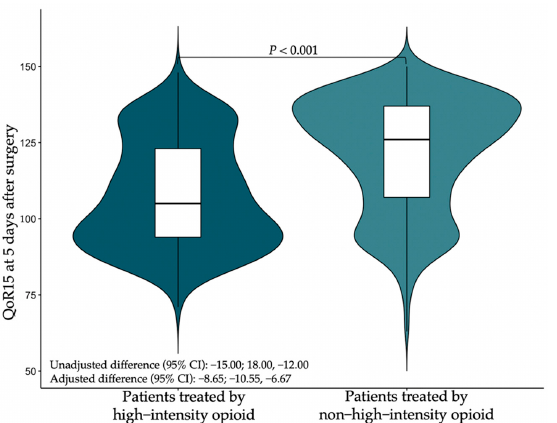
Figure 3. Violin plot of patient QoR-15 scores at 5 days after surgery. Abbreviations: QoR-15, Quality of Recovery—15; CI, confidence interval. Cyan represents patients treat by “high-intensity” opioid; Light cyan represents patients treated by “non-high-intensity” opioid. Patients in the high-intensity group took longer to get out of bed after surgery (MD 4.31 h; 95% CI, 2.81 to 6.48, p = 0.001), a difference that was clinically small (Table 4). These Table 4. Regression analyses to identify associations between intensity of postoperative opioid use individuals also required a longer use of urine catheters (MD 12.26 h; 95% CI, 8.97 to 16.95, and secondary p < 0.001) and longer hospitalization after surgery (MD 1.17 days; 95% CI, 1.06 to 2.07, p < 0.001). CPSP occurred in 113 of 293 patients (38.57%) that were given high-intensity opi- oids compared to 240 of 877 patients (27.37%) given non-high-intensity opioids. These proportions were significantly different after adjusting for potential confounders (OR 1.54; 95% CI, 1.14 to 2.08, p = 0.005). In contrast, the two groups did not differ significantly in the incidence of PONV or pruritus.